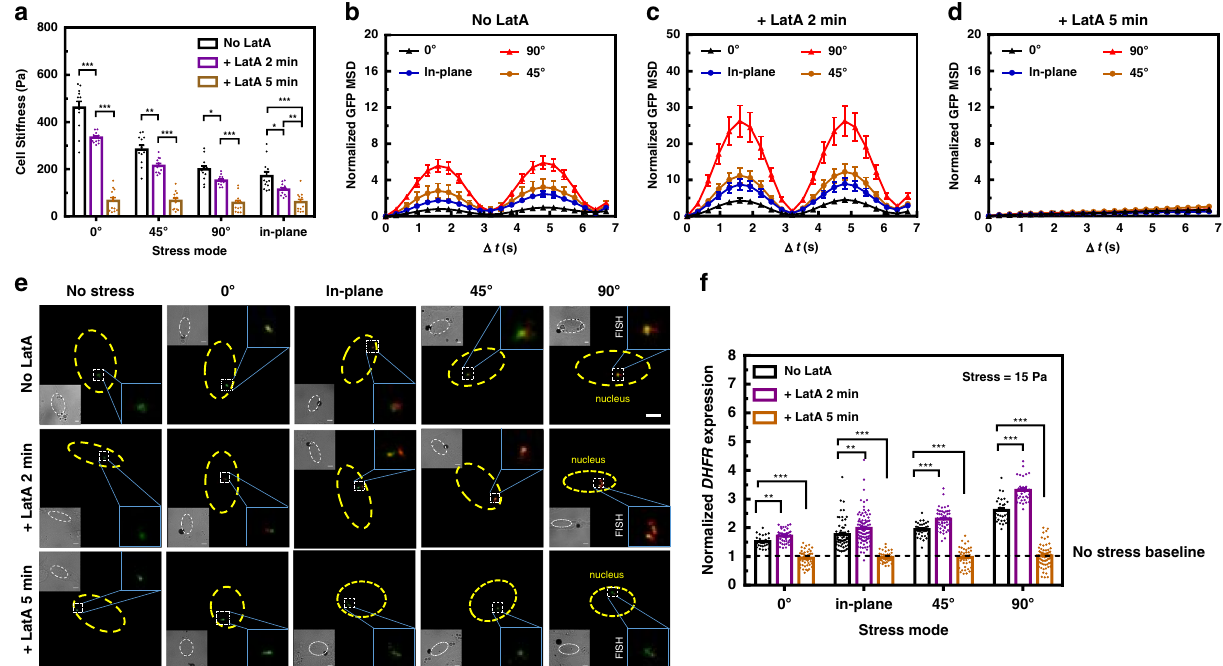
Fig. 4 Actin stress fi bers dominate cytoskeletal anisotropy-dependent cellular responses. a Cell stiffness under different stress modes before adding Latrunculin A (No LatA control), after adding Latrunculin A (1 μ M) for 2 min ( + LatA 2 min) or 5 min ( + LatA 5 min). P = 0.0075 between No LatA and + LatA 2 min under 45° stress mode; P = 0.023 between No LatA and + LatA 2 min under 90° stress mode; P = 0.039 between No LatA and + LatA 2 min and P = 0.0032 between + LatA 2 min and + LatA 5 min under in-plane stress mode; P < 0.001 between other conditions under each stress mode. Mean ± s.e.m.; n = 12 cells; nine independent experiments. * P < 0.05; ** P < 0.01; *** P < 0.001. Normalized mean squared displacement (MSD) of all individual GFP spots when the stress (15 Pa at 0.3 Hz) was applied at 0°, 45°, or 90° out-of-plane mode or in-plane mode before adding LatA ( b ), after adding LatA for 2 min ( c ), or for 5 min ( d ). Mean ± s.e.m.; n = 12 cells, nine independent experiments. e Representative images of RNA FISH at no stress, 0°, 45°, or 90° out-of-plane mode or in-plane mode. Stress (15 Pa at 0.3 Hz) was applied before adding Latrunculin A (No LatA control), after adding Latrunculin A for 2 min ( + LatA 2 min), or 5 min ( + LatA 5 min). The yellow dashed lines highlighted the area of the nucleus. The GFP chromatin domains (green color) and the DHFR FISH fl uorescence (red color) in the white box of each image were enlarged and shown on the right. The bright fi eld image of each cell was shown in an inset at the left site and the scale bar was 3 μ m within each inset. The black dot was the magnetic bead attached to the cell surface. The nucleus was highlighted with a dashed line. The scale bar on the top right panel was 3 μ m. f DHFR transcription varies with duration of LatA treatment for both in-plane and out-of-plane modes. P = 0.0023 between No LatA and + LatA 2 min under 0° stress mode; P = 0.0048 between No LatA and + LatA 2 min under in- plane stress mode; P < 0.001 between other conditions under each stress mode. Mean ± s.e.m.; 0°: n = 38, 45, and 47 cells; in-plane: n = 58, 89, and 41 cells; 45°: n = 35, 52, and 40 cells; 90°: n = 28, 31, and 62 cells for No LatA control, + LatA 2 min and + LatA 5 min, respectively; three independent experiments. Control was the cells applied with the same stress but not treated with LatA. ** P < 0.01; *** P < 0.001. The dashed line indicated the DHFR gene expression levels without applying the stress. P values were calculated and corrected using two-tailed Student ’ s t -test and Bonferroni correction. Source data are provided as a Source data fi